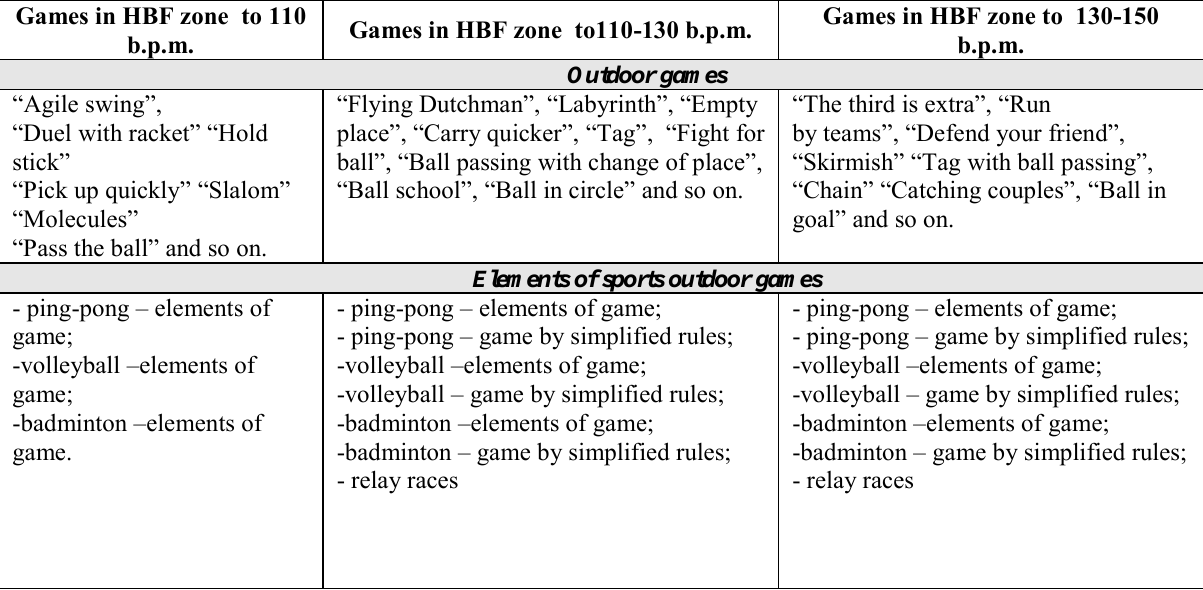
Systemizing of game exercises, adapted for physical loads, which are recommended for SHG students with CV problems Games in HBF zone to